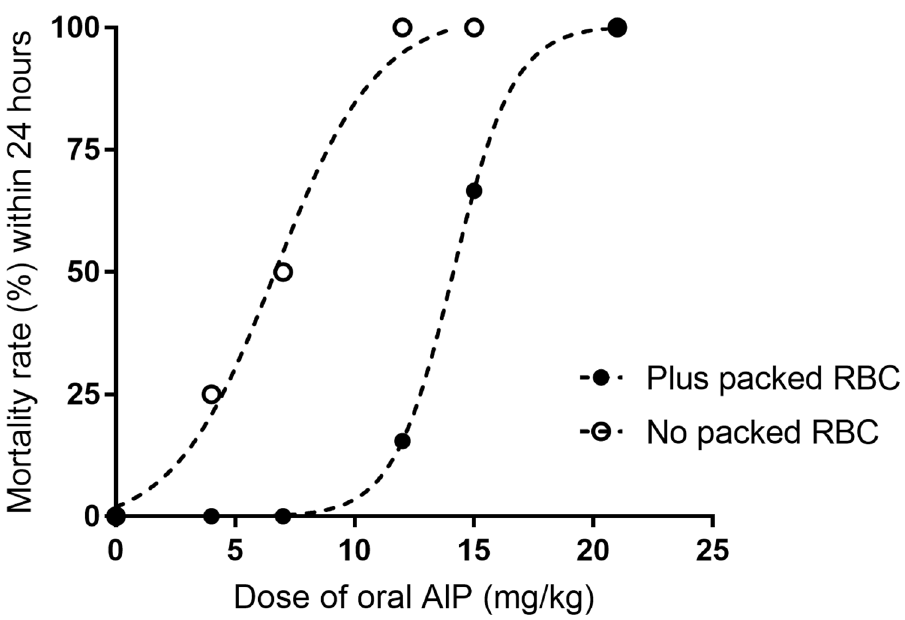
Fig 4. Dose-dependent motility curves for the toxic effect of aluminum phosphide (AlP) in rats with or without transfusion of packed red blood cells (RBC). Packed RBC (1.5 ml) was infused one hour after oral administration of different doses of